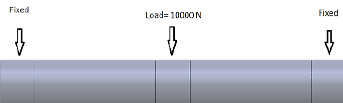
Figure 6: Boundary